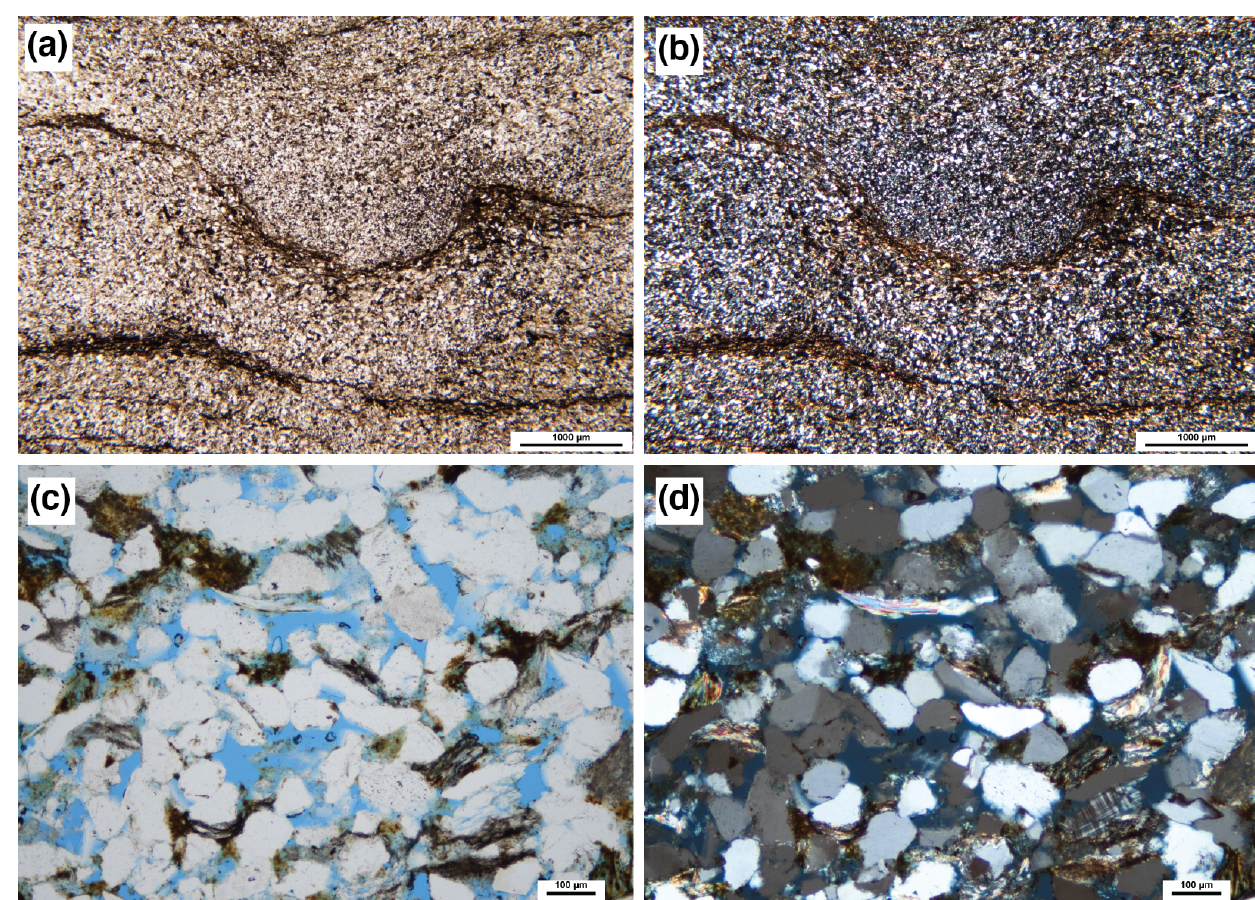
Figure 5. Thin section images from American Vitrified 2, used in Part 3 of the assignment for students to precisely determine lithologies. (a) Sample AV 2-1 in PPL, the organic-rich mudstone from Fig. 4, (b) sample AV 2-1 in XPL from Fig. 4, (c) sample AV 2-2 in PPL, the sandstone from Fig. 4, and (d) sample AV 2-2 in XPL from Fig. 4. Scale bars in (a) – (b) are 1000µm, and scale bars in (c) – (d) are